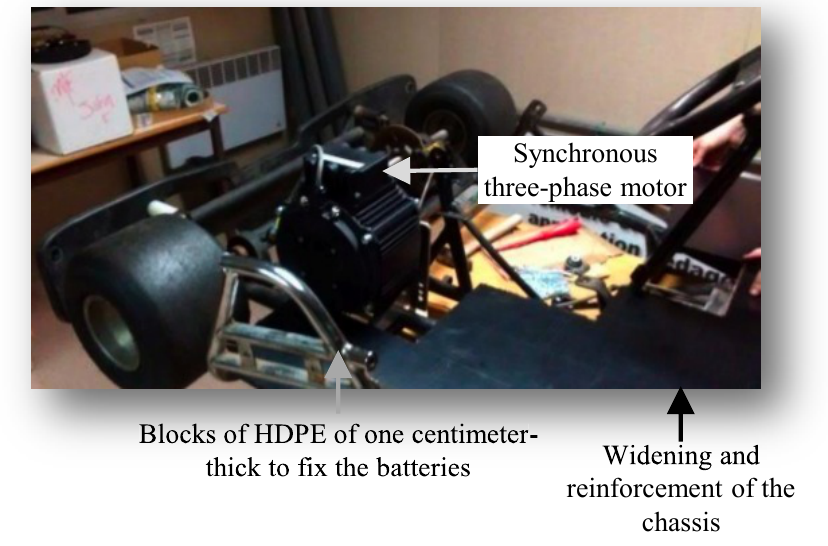
Fig. 2. Lightering, widening and reinforcement of the